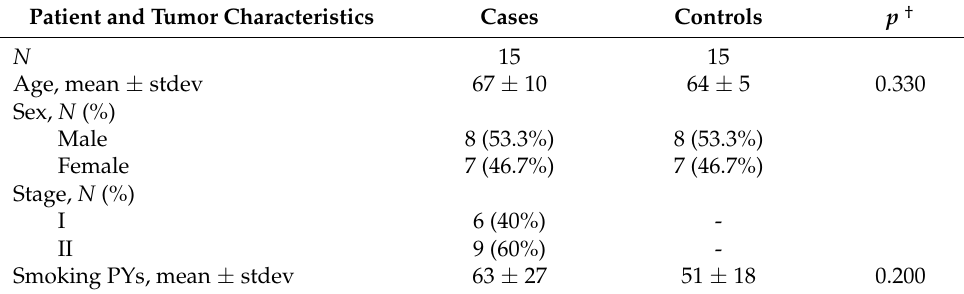
Table 1. Patient and tumor characteristics for MDACC Cohort.